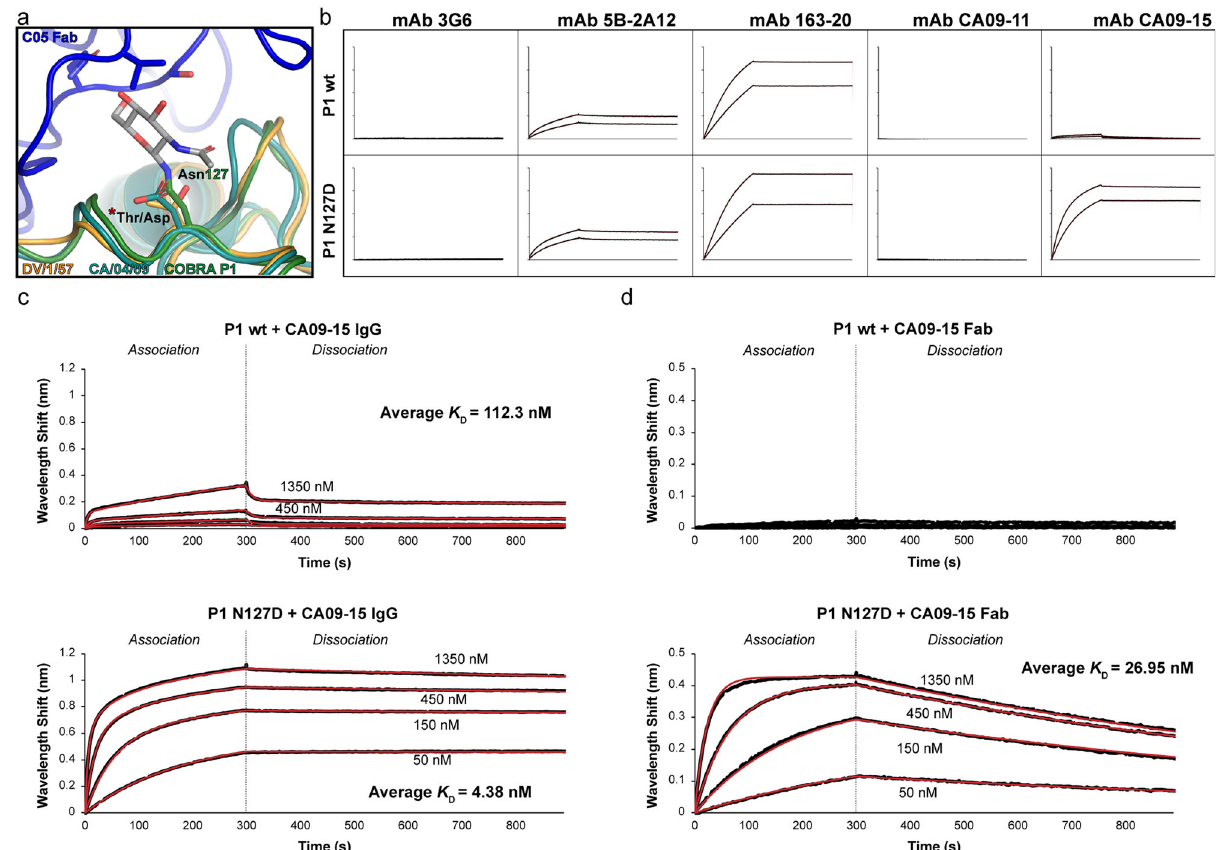
Fig. 4 Impact of Asn127 glycosylation on antibody binding with COBRA P1. a Closeup of Asn127 of COBRA P1 overlayed with structures of CA/04/09 (PDB 3LZG) and DV/1/57 bound to the RBS-targeting antibody C05 (PDB 6ML8). b Biolayer interferometry of wildtype and N127D mutant COBRA P1 with antibodies known to target the head domain of CA/04/09 HA. c Kinetics of mAb CA09-15 binding with wildtype and mutant COBRA P1 measured by biolayer interferometry. Representative traces of the processed data are shown. The K D value represents the mean of two independent experiments. d Kinetics of Fab CA09-15 binding with wildtype and mutant COBRA P1 measured by biolayer interferometry. Representative traces of the processed data are shown. The K D value represents the mean of two independent